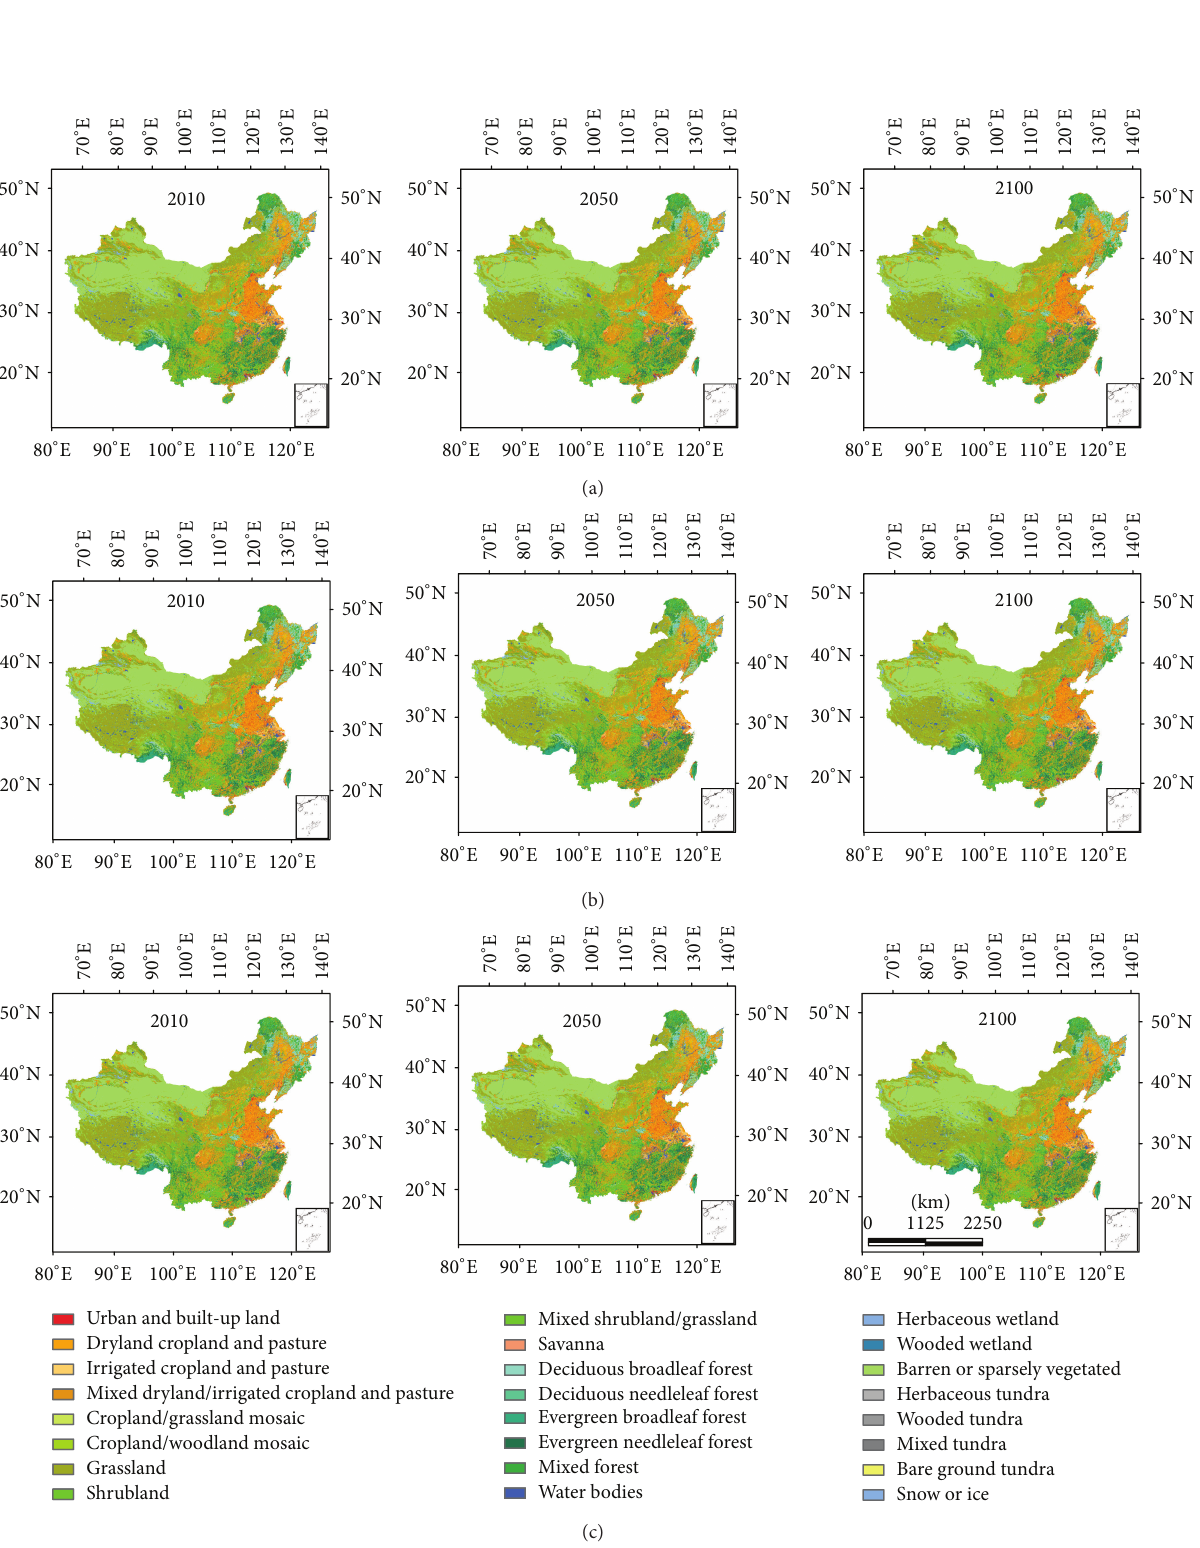
Figure 3: Simulated spatial pattern of LUCC in China in 2010, 2050, and 2100 under the Business as Usual scenario (a), Rapid Economic Growth scenario (b), and Cooperate Environmental Sustainability scenario